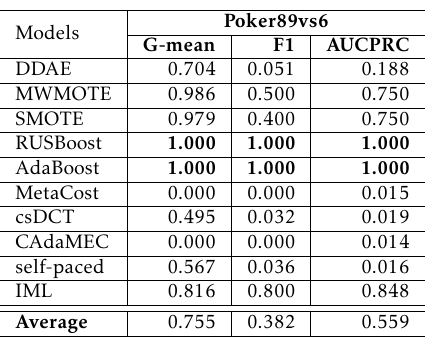
Table 17. Overall Results for Poker89vs6 Dataset